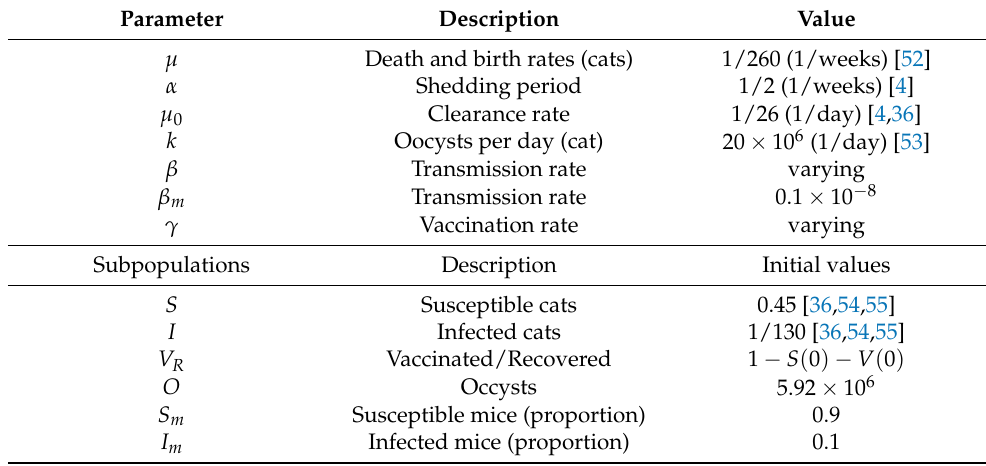
Table 1. Baseline values for the parameters and subpopulations. Parameter Description Value µ Death and birth rates (cats) 1/260 (1/weeks) [52] α Shedding period 1/2 (1/weeks) [4] Clearance rate 1/26 (1/day) [4,36] Oocysts per day